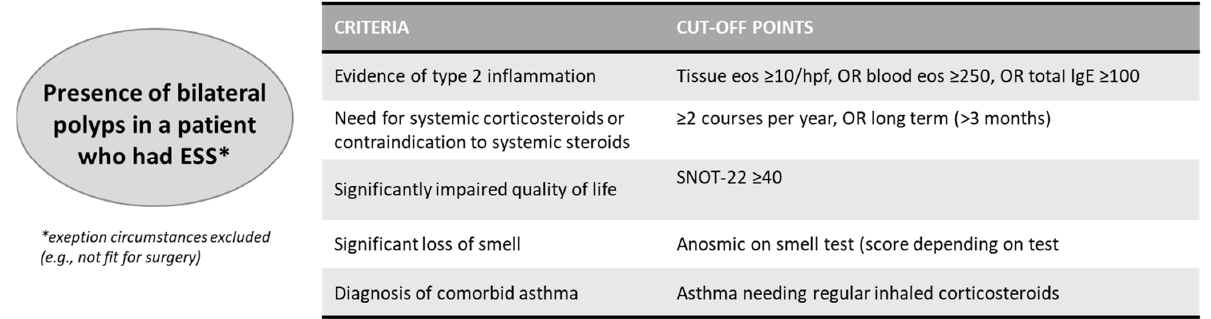
Figure 1. Criteria for biological treatment in CRSwNP. Eos: eosinophils; Hpf: high power field; SNOT-22: 22-item Sino-Nasal Outcome. Adapted from EPOS 2020.